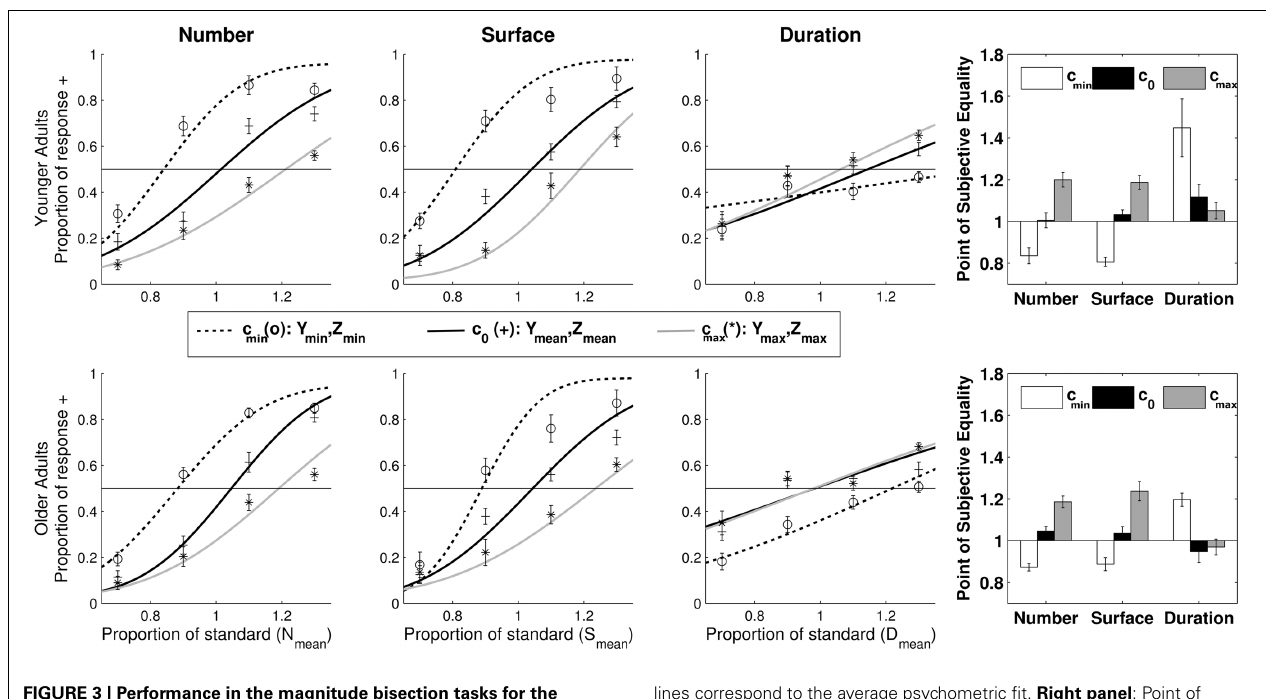
lines correspond to the average psychometric fit. Right panel : Point of Subjective Equality for the number, cumulative area and duration task in the three experimental conditions c 0 ( Y mean , Z mean ), c min ( Y min , Z min ) and c max ( Y max , Z max ). Error bars show standard error of the